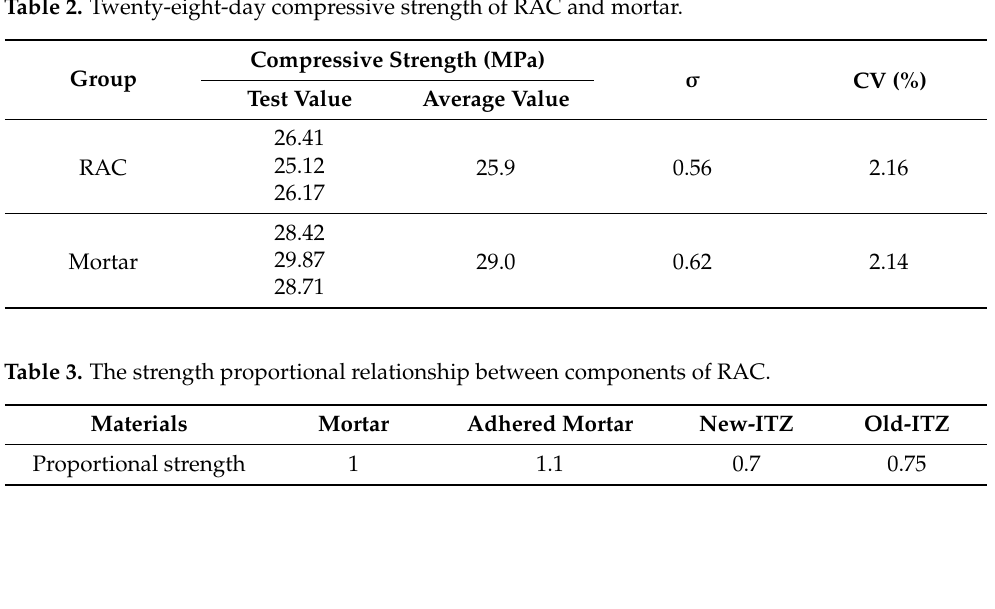
Table 2. Twenty-eight-day compressive strength of RAC and mortar.